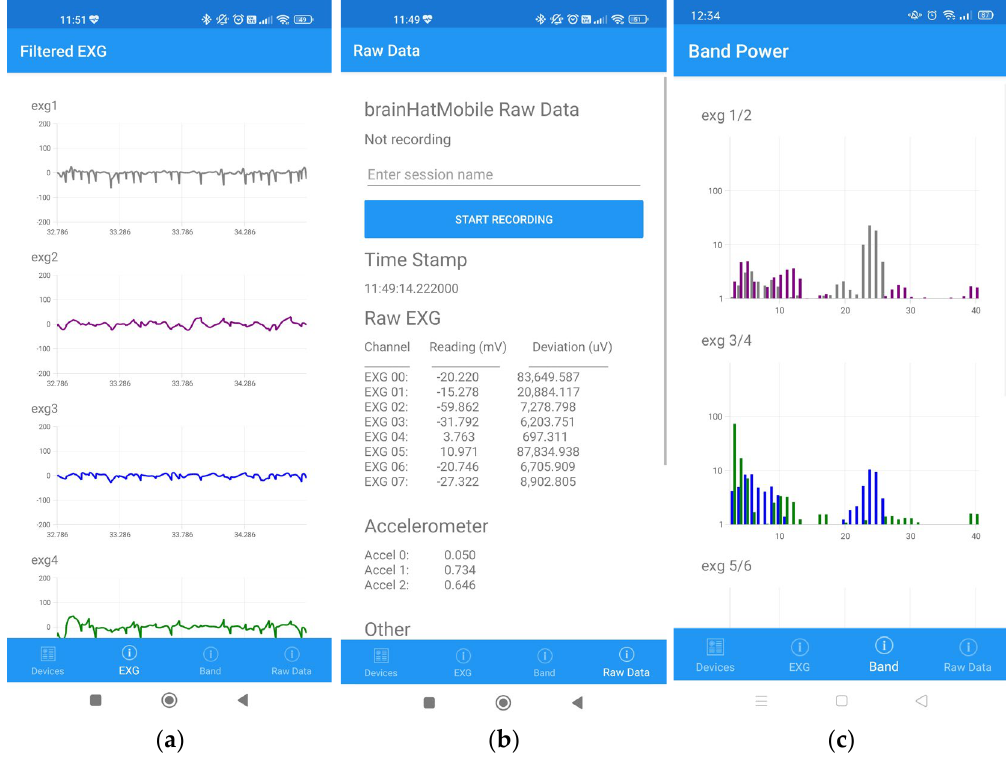
Figure 8. Mobile application. ( a ) Filtered EXG screen. ( b ) Raw Data screen. ( c ) Band Power screen.